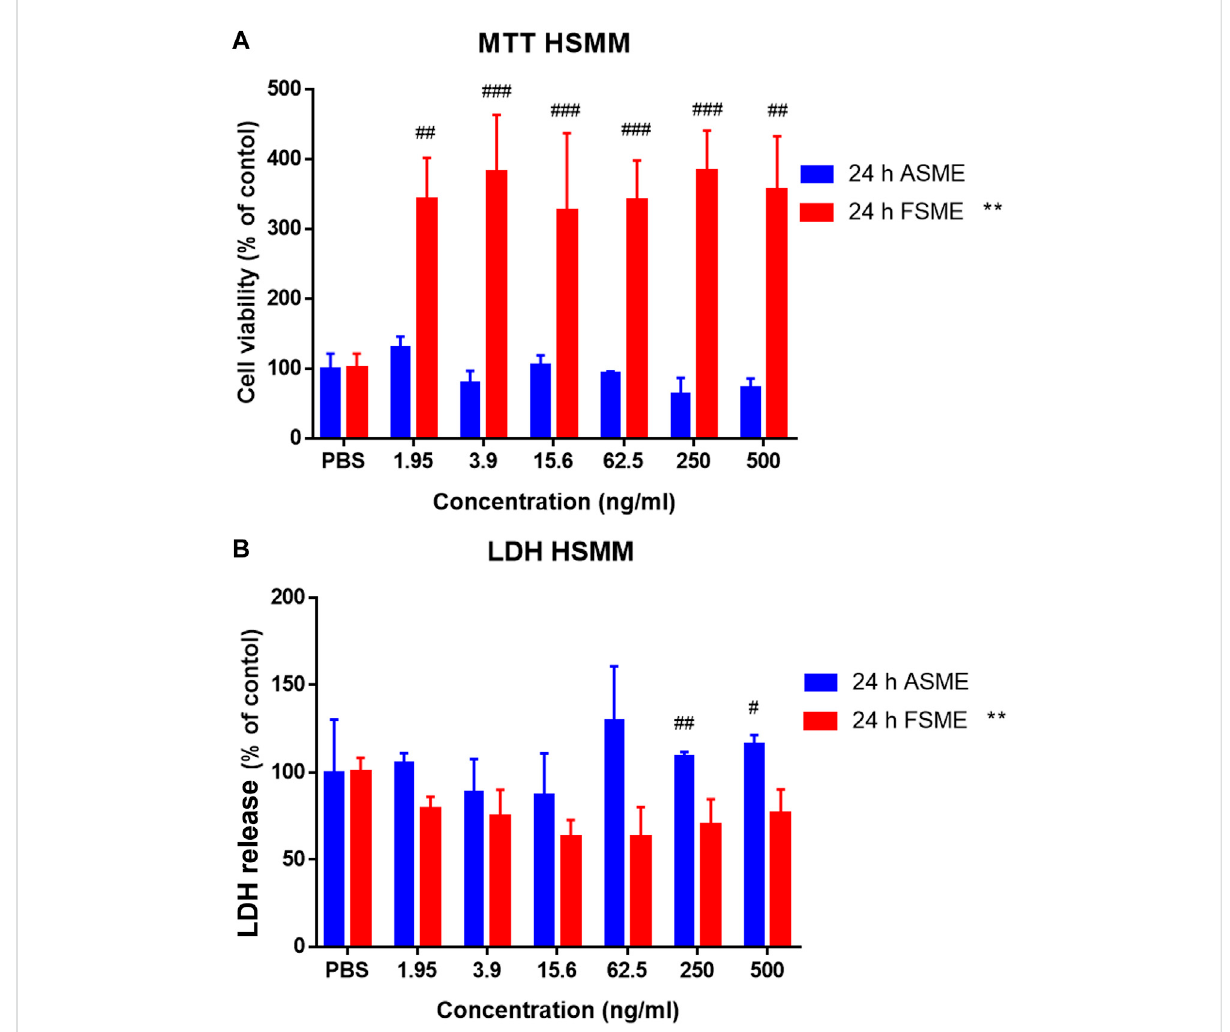
FIGURE 3 Cytotoxic effects of ASME and FSME in HSMM. (A) Cell viability was assessed by the MTT assay. Cells were incubated with increasing concentrations (1.95 – 500 ng/ml with a 2-fold increase) of ASME or FSME in a culture medium for 24 h. PBS was used as vehicle control. Results are expressed as the percentage of absorbance (the ratio of absorbance in ASME or FSME to that of PBS). (B) Effects of ASME and FSME on inducing plasma membrane damage in HSMM by LDH assay. HSMM cells were treated with PBS as vehicle control and ASME and FSME at 1.95 – 500 ng/ ml (2-fold increase) for 24 h. After 24 h of ASME treatment, 250 ng/ml and 500 ng/ml signi fi cantly induced plasma membrane damage in HSMM. Data are means ± SD of three independent experiments. ** represents p < 0.01 indicates signi fi cance compared with FSME. ## represents p < 0.01 and # represents p < 0.05 indicate signi fi cance compared with control in ASME by one-way ANOVA, Dunn ’ s multiple comparisons test. N = 3; results are presented as mean ±